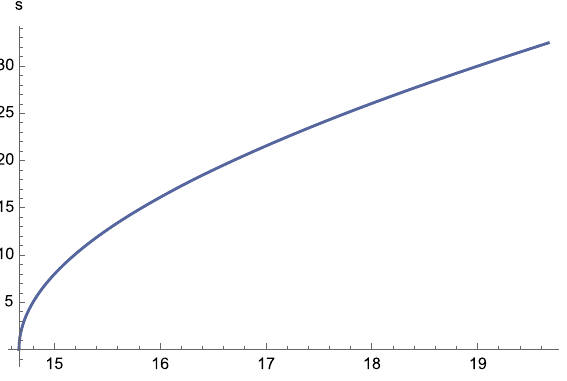
Fig. 15 The function s = s ( r ) for first-kind orbits having C 2 E 2 < 1. The following constants have been chosen: s 0 = 0, M = 2, e = 4 . 5, (cid:10) = 11, ε = ± 1, and C =